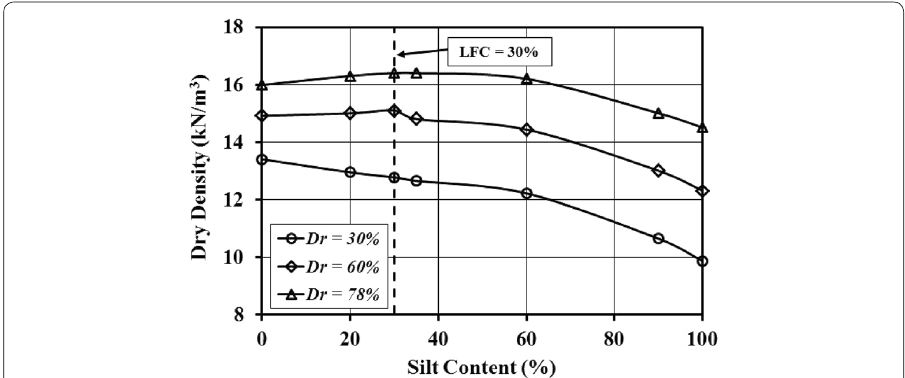
Fig. 26 Variation of dry density with silt content at constant relative